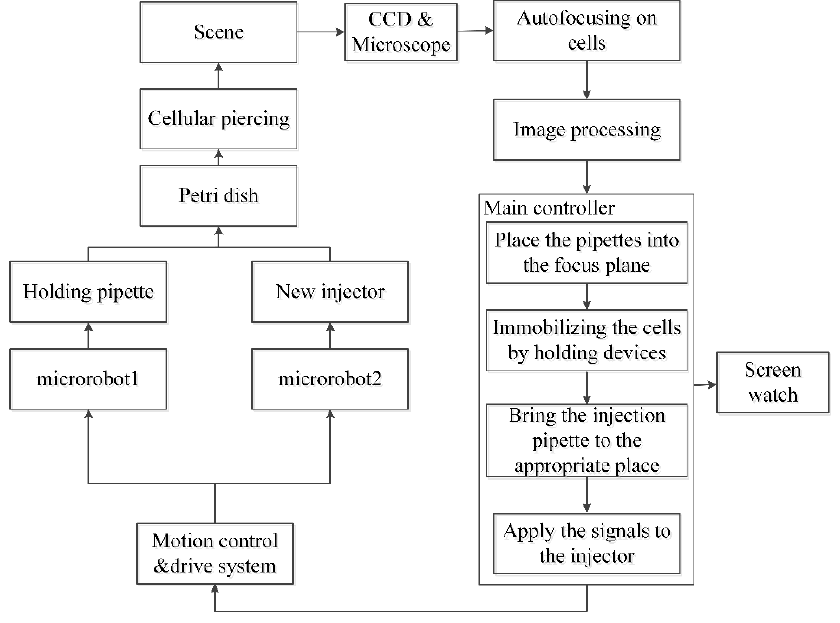
Figure 6. Cellular piercing flow chart.